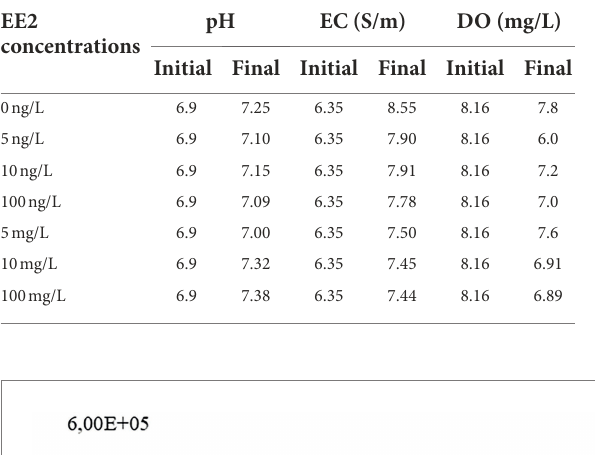
TABLE 1 Physicochemical characteristics of control and treated samples following a 6-days incubation at different EE2 concentrations.